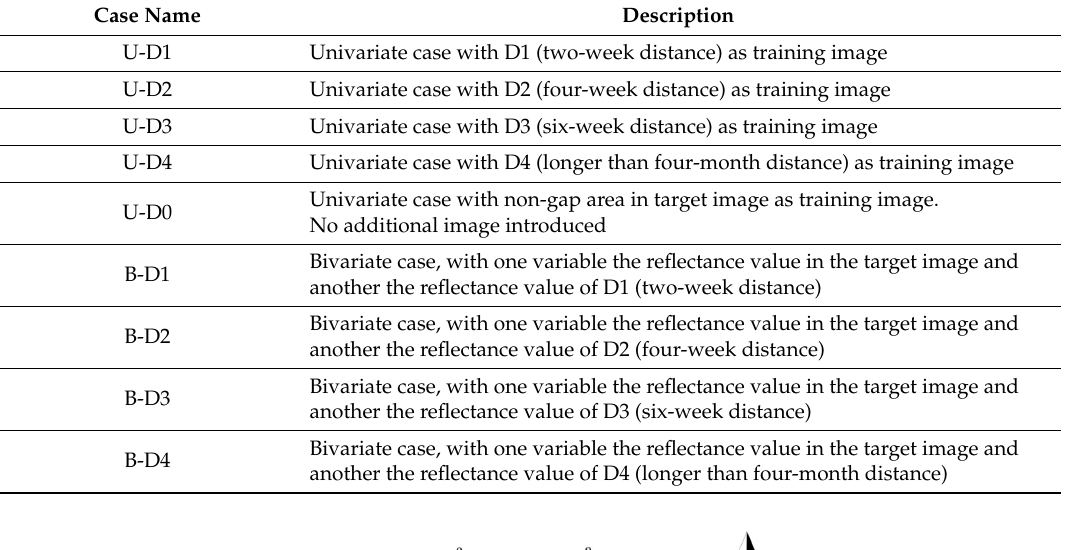
Table 3. Nine individual cases considered for each land cover type.